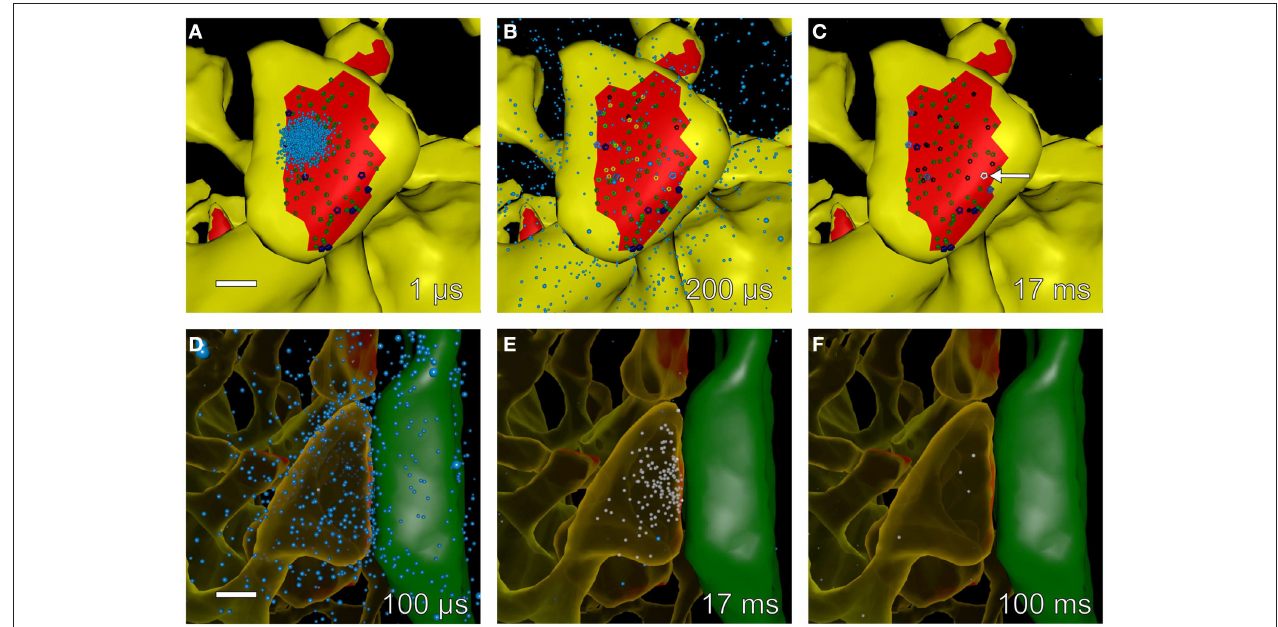
FIGURE 8 | Snapshots of simulated glutamate release and postsynaptic calcium dynamics at different times during an EPSP + bAP stimulus. We used Cell Blender (see Methods Section) to visualize simulated glutamate release and calcium entry into spine #37 (see Figure 4A ) during an EPSP + bAP stimulus. All other components of the neuropil were present in the simulation but are not displayed in the visualization. All scale bars are 0.25 µ m. (A–C) Time-lapse sequence of glutamate (cyan dots) released onto a dendritic spine with unbound AMPARs (smaller, dark-green glyphs) and unbound NMDARs (larger, dark-blue glyphs). Snapshots (A–C) were made from data generated by MCell during a single trial and taken at 1, 200 µ s, and 17ms after glutamate release, respectively. Glutamate diffused rapidly throughout the synaptic cleft, binding to AMPARs and NMDARs. Singly bound AMPARs are shown as medium-green glyphs, doubly bound AMPARs as bright-green glyphs, open AMPARs as yellow glyphs, and desensitized AMPARs as black glyphs. Singly bound NMDARs are shown as medium-blue glyphs, doubly bound NMDARs as bright-blue glyphs, and open NMDARs as white glyphs. During this trial the peak of AMPAR activation occurred at ∼ 200 µ s and the peak of NMDAR activation occurred at ∼ 17ms when a single NMDAR flickered open (white glyph indicated by white arrow in C ). (D–F) Time-lapse sequence of glutamate decay and calcium influx after stimulation. Snapshots for (D–F) were made from data generated by MCell during a single trial and taken at 100 µ s, 17, and 100ms after glutamate release, respectively. The presynaptic axon (green) on the right makes an en passant synapse with the postsynaptic spine (translucent yellow) on the left. Free glutamate molecules (cyan dots) diffuse from the synaptic cleft within a few microseconds and are taken up within a 100ms by astroglial transporters (not visualized but present in the simulation). Some glutamate remains bound and activates NMDARs for many tens of microseconds allowing influx of calcium (white dots) as NMDARs flicker open and closed. In this example, calcium entered the spine through a single open NMDAR and was cleared from the spine head via calcium pumps in the spine membrane and by diffusion through the spine